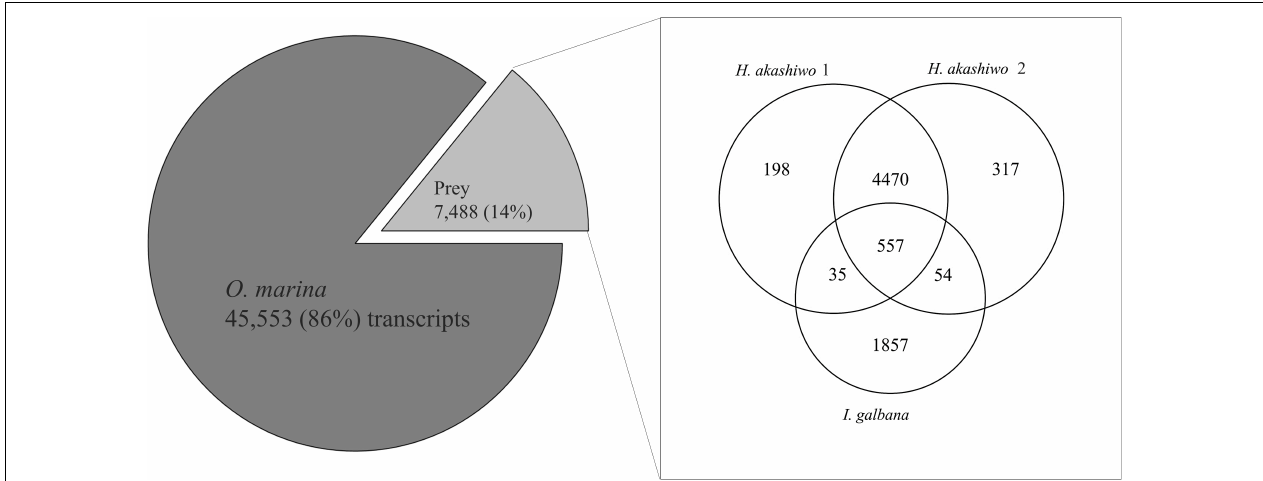
FIGURE 2 | Results of blastn homology searches of contigs from the combined predator–prey assembly (metatranscriptome) against each of the three prey-only assemblies. A total of 7,488 contigs (14% of the assembly) in the metatranscriptome matched at least one of the prey contigs at a percent nucleotide identity ≥ 79.5%. The number of contigs assigned to each prey species varied (Venn diagram). The remaining 86% of the contigs were considered prey-free O. marina contigs and were used for DE analysis. TABLE 3 | The results of quality filtration and mapping of sequence reads to O. marina transcripts. Number of paired reads mapped to the Sample MMETSP Number of paired Number of paired reads O. marina transcriptome number reads (2 ∗ 50 bp) after quality filtration Mapped